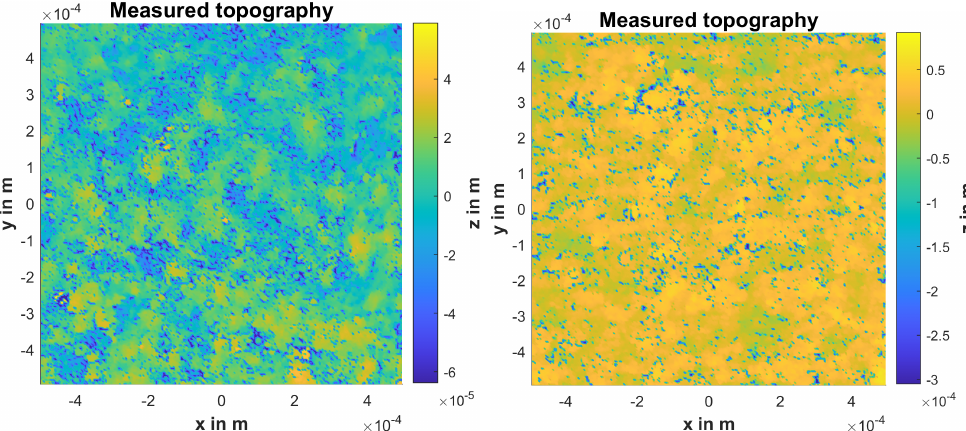
Figure 7. Measured topography used in the simulations for the ( left ) upwards- and ( right ) sidewards- facing